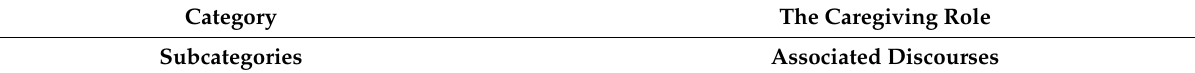
Table 5. Category R: The caregiving role.